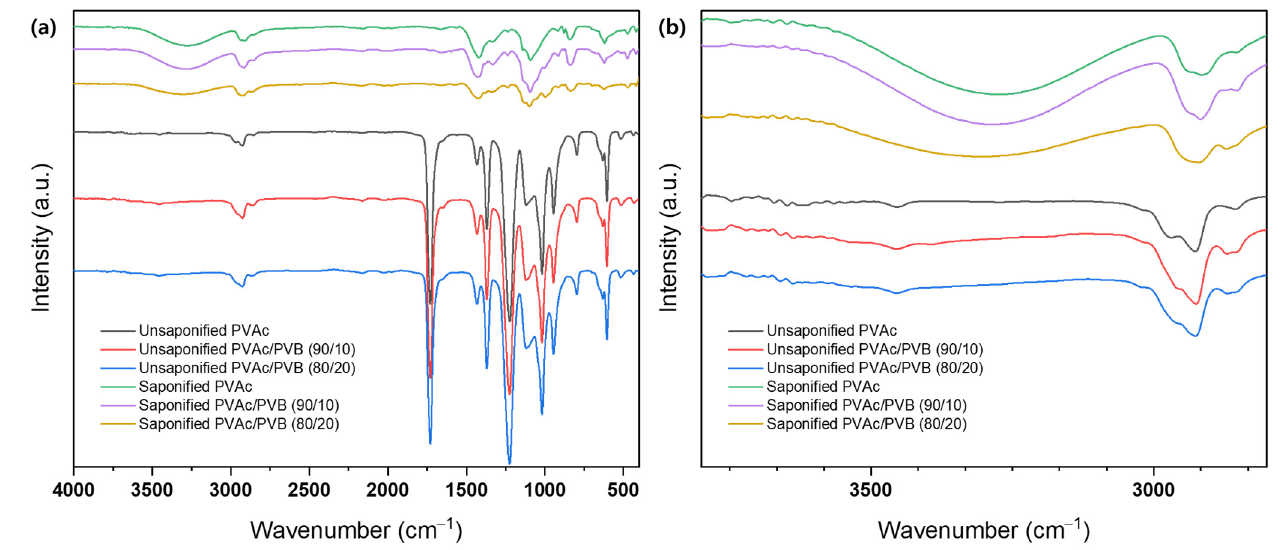
Figure 3. FTIR spectra of various film samples at ( a ) 4000 − 500 cm − 1 and ( b ) 3500 − 3000 cm − 1